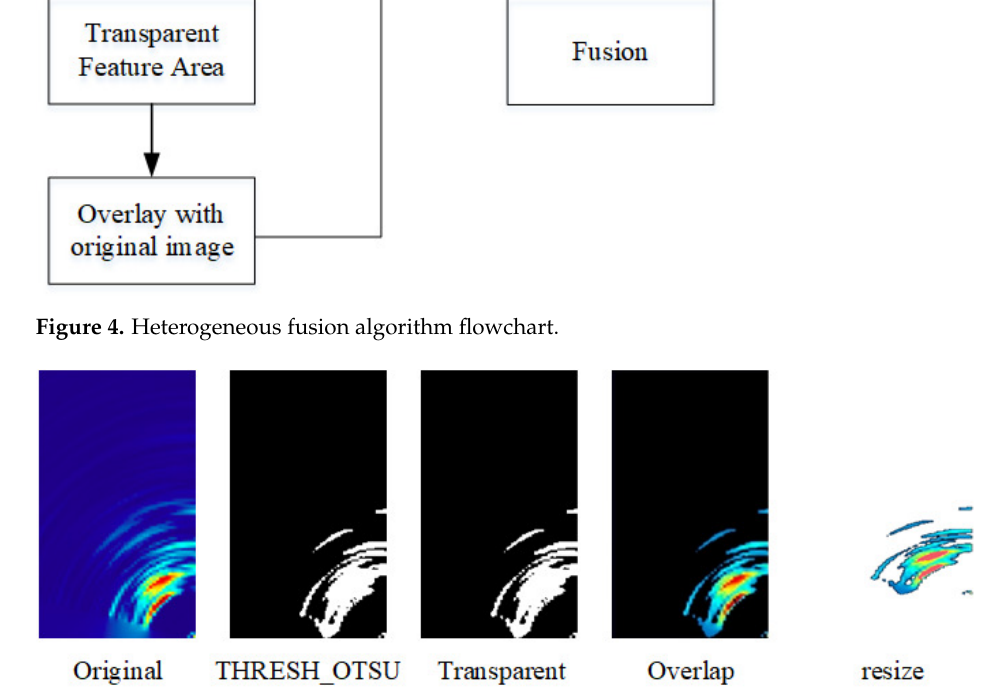
Figure 5. Binarization process of the mmWave radar